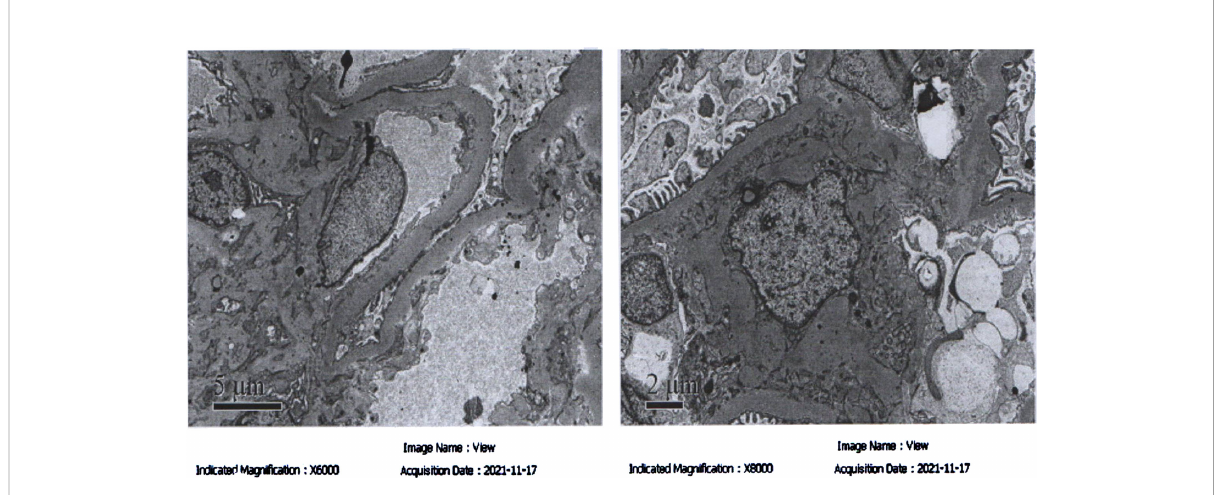
FIGURE 2 The electron microscope results of the patient. The black arrow indicates the